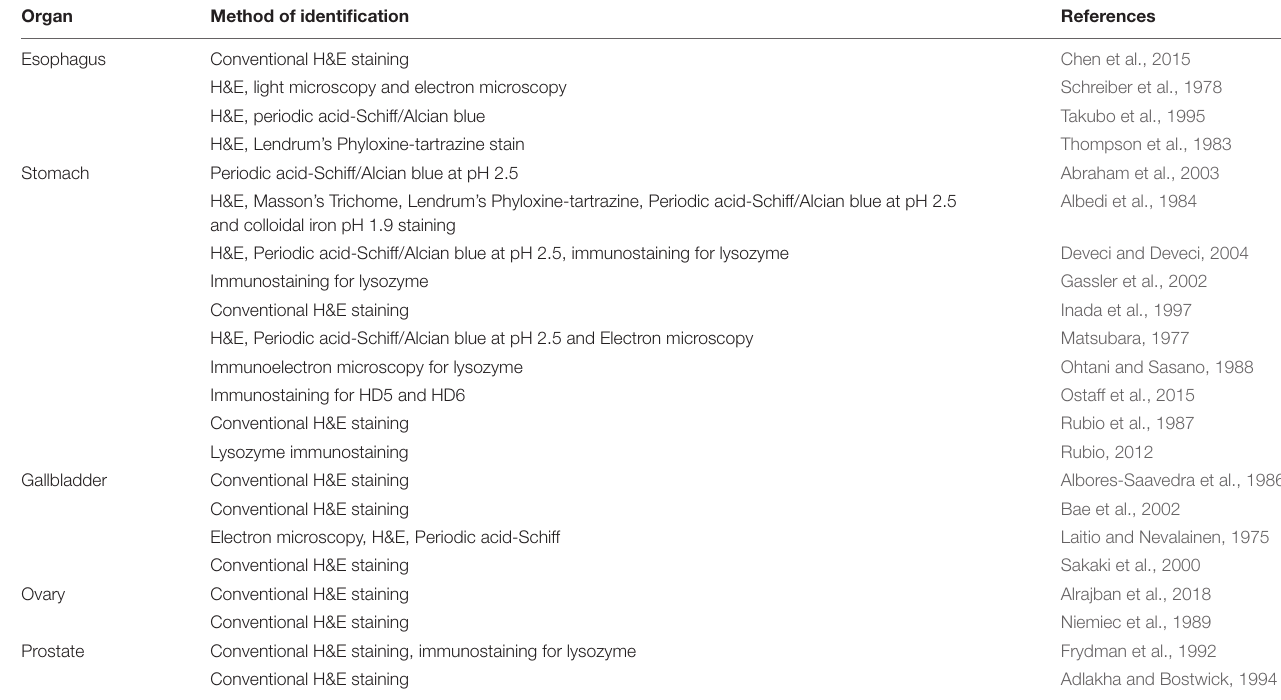
TABLE 1 | Methods used for identification of metaplastic Paneth